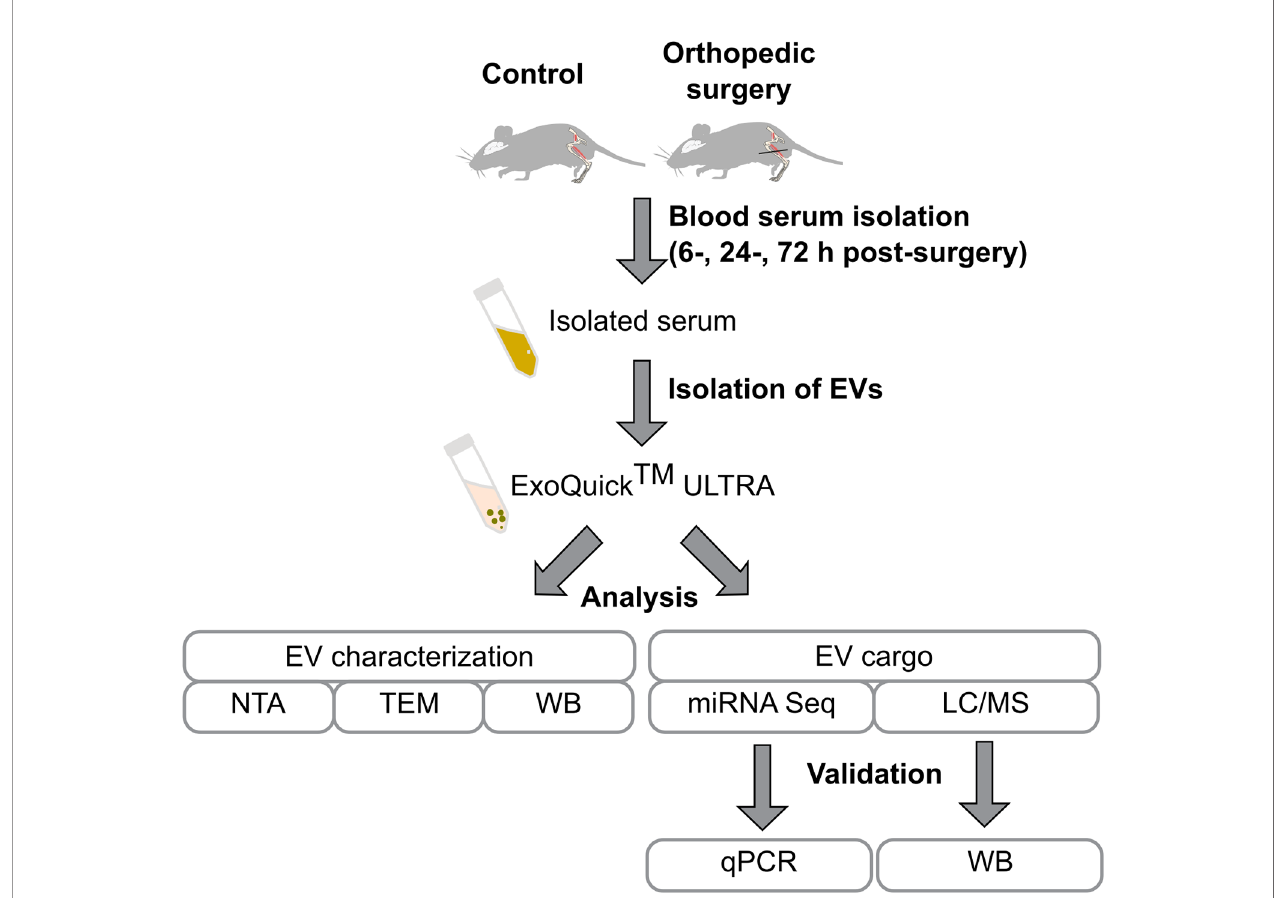
FIGURE 1 | Flowchart of the study design. Mice were subjected to tibia surgery, blood was collected from the control and surgery animals after 6, 24, and 72 h post-surgery. Isolated blood serum was used for the puri fi cation of EVs using the ExoQuick ULTRA kit. EVs were characterized by Nanoparticle Tracking Analysis (NTA), transmission electron microscopy (TEM), and identi fi cation of EV enriched proteins by western blot. EVs ’ proteome and miRNAome were investigated by LC/ MS and RNA-seq and fi ndings were validated by qPCR and western